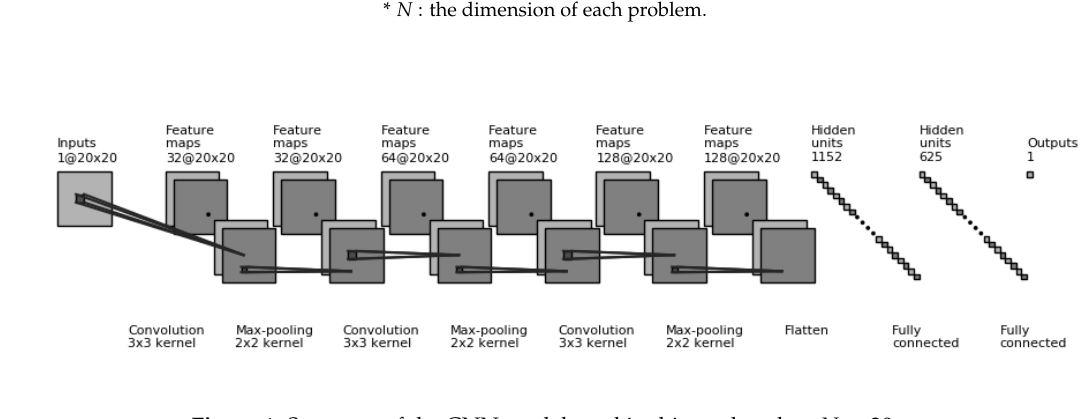
Figure 1. Structure of the CNN model used in this study, when N =